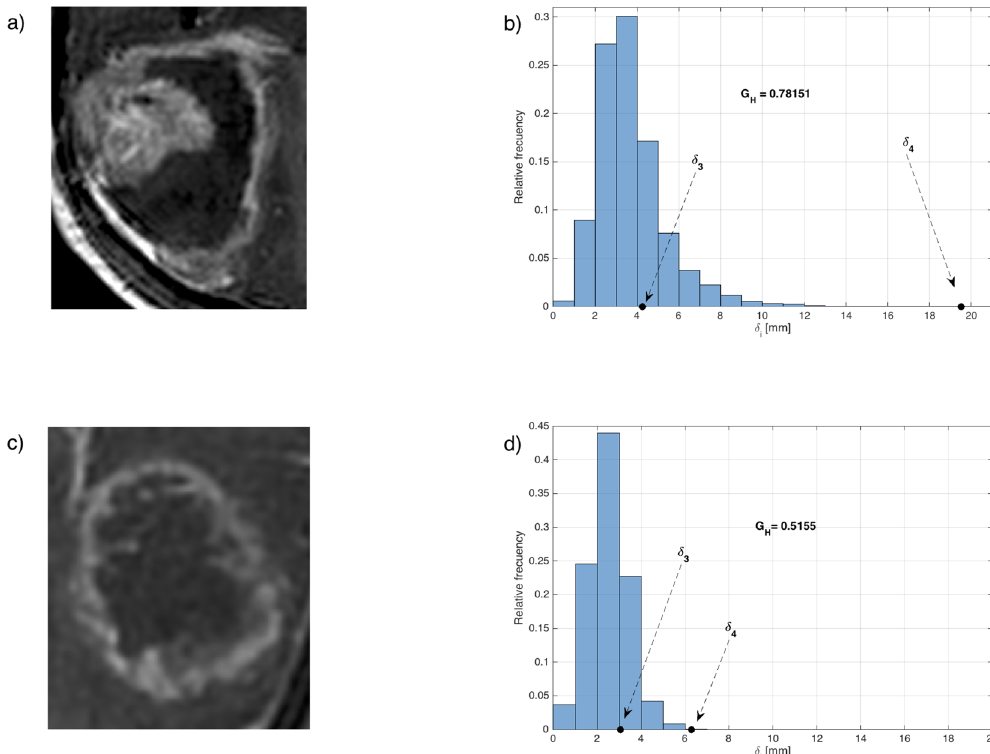
Fig 1. Visual examples of two tumors with different geometric heterogeneities. The first case corresponds to a rim-heterogeneous tumor (Fig 1A and 1B), having large geometric heterogeneity. The second case is a geometrically regular tumor (Fig 1C and 1D), with smaller geometric